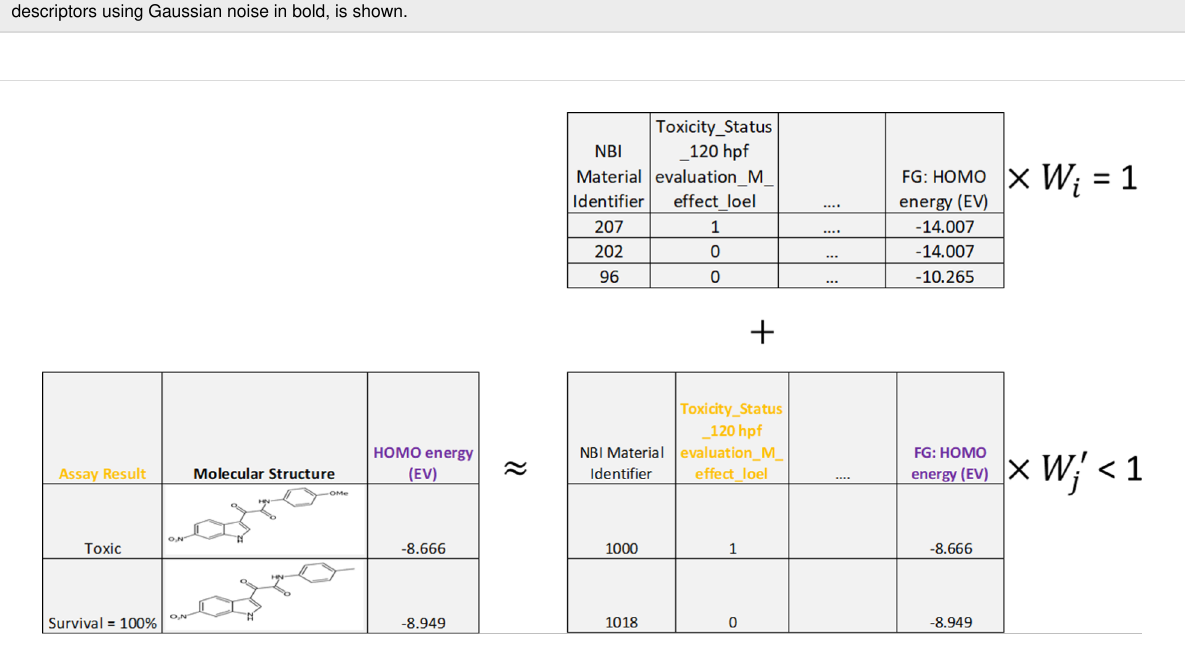
Figure 5: Data augmentation using the “weighted alternative samples” paradigm, where the alternative samples were derived from molecular toxicity data reported in the ChEMBL database corresponding to whether mortality was (“toxic”) or was not (“survival = 100%”) observed after three days, when compounds were tested at 5 μ M at 48 hpf on zebrafish. Top: a subset of the available training set ENM samples and the corresponding descrip- tors is shown. The weighting of these true samples during training ( W i ) was set to 1.0. Bottom: the addition of some of the available pseudo-ENM samples is shown, where these pseudo-ENM samples were derived by treating the compounds as outermost surface functional groups from ENM samples, with all other ENM descriptors set to dummy values assigned to inapplicable descriptors. The weighting of these pseudo-samples during training ( ) was set to a value less than